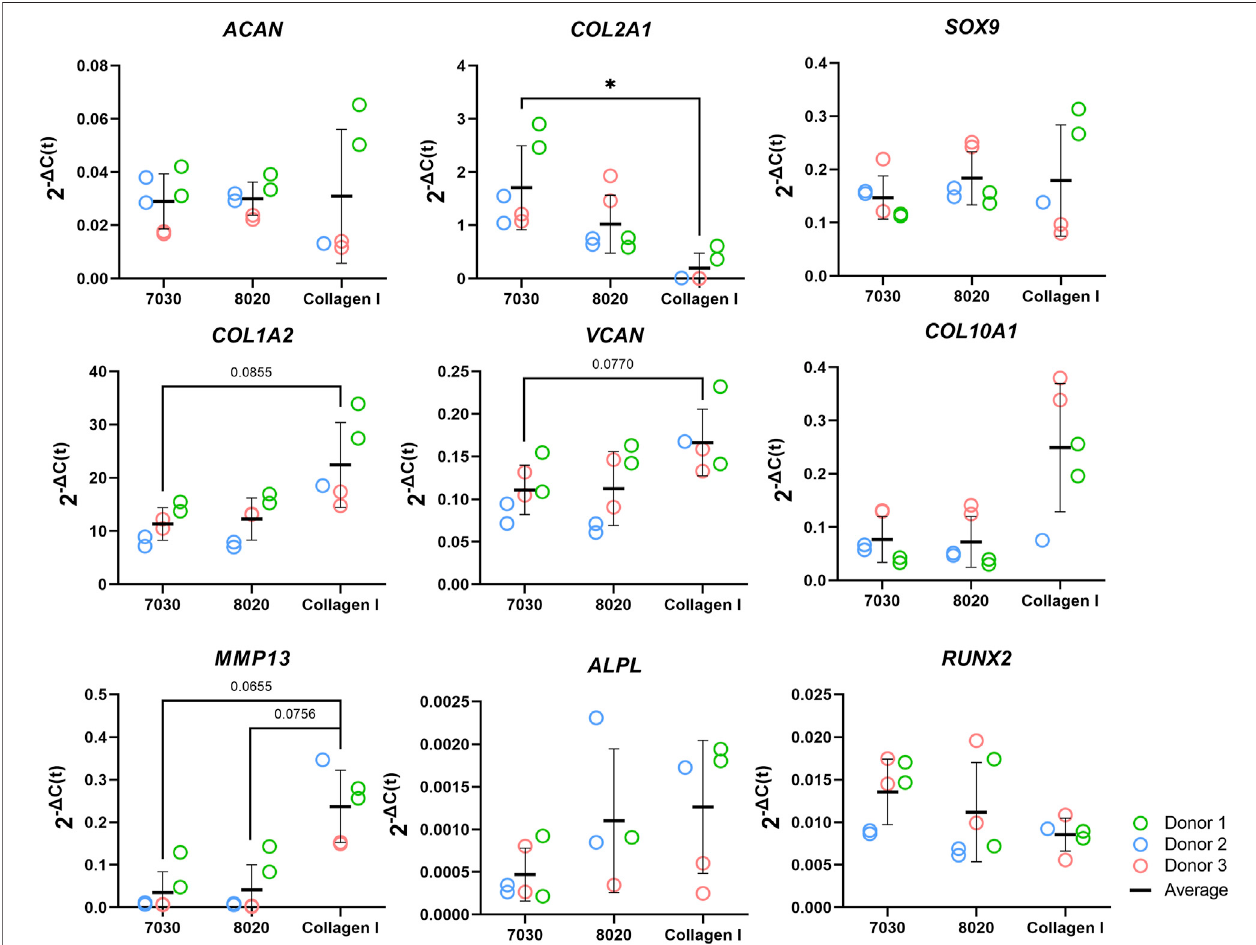
FIGURE 8 | Fibrocartilage related gene expression of bioprinted constructs after 6 weeks of in vitro chondrogenic culture ( n (cid:1) 3). * represents p < 0.05.